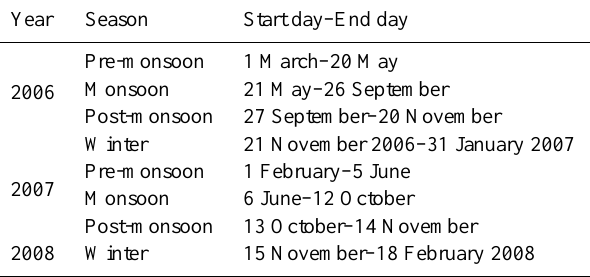
Table 1. Identification of season transitions as a function of the local weather regime at NCO-P (from Bonasoni et al., 2010)